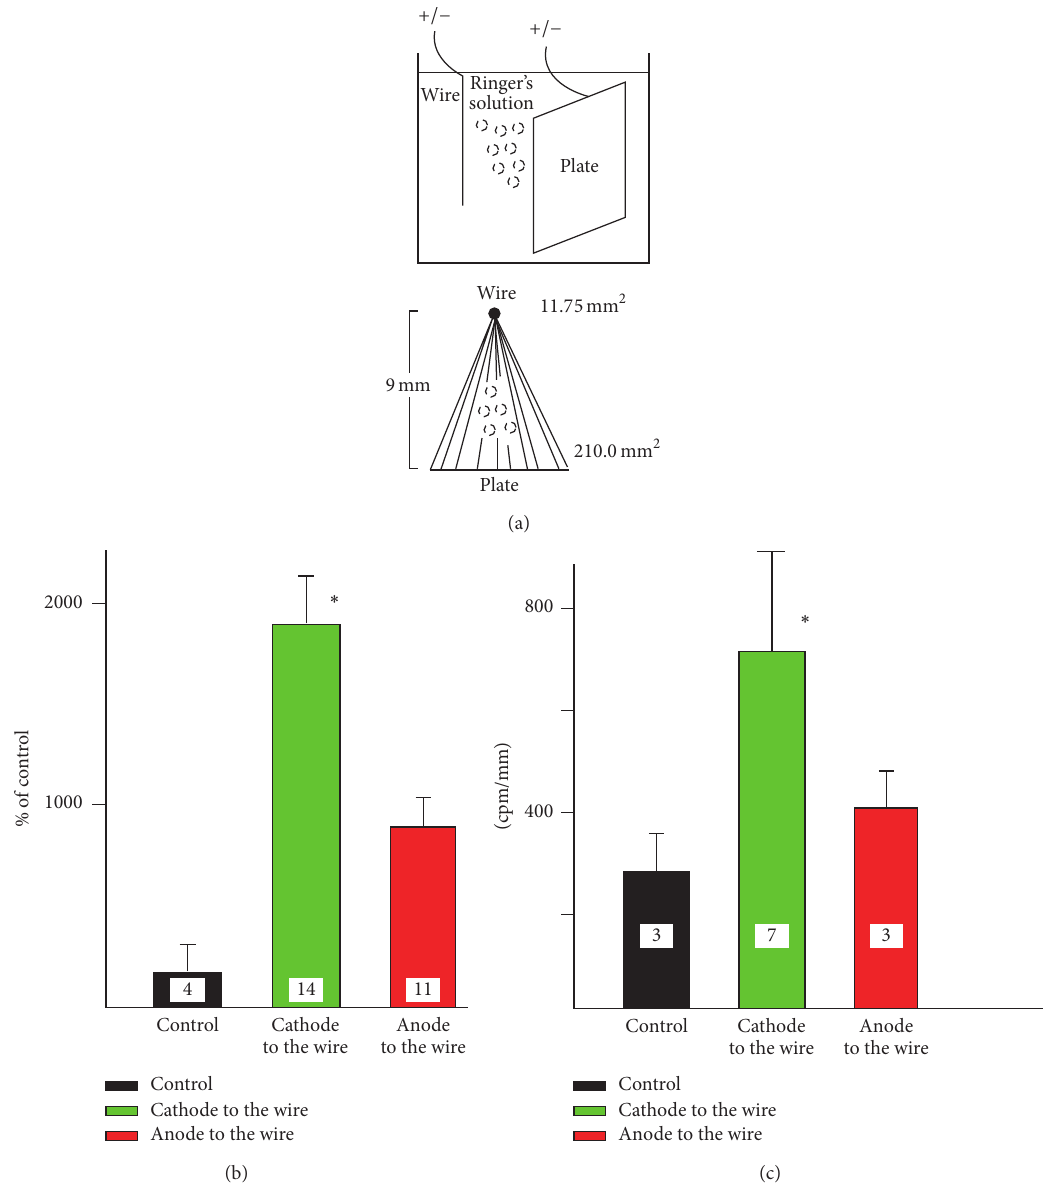
Figure 6: Accumulation of 45 Ca 2+ by synaptosomes and segments of the sciatic nerve stimulated with two electrodes of different areas. (a) An experimental setup. The stainless steel plate (210 mm 2 ) was inserted into the plastic tube at the distance of 9 mm from the stainless steel wire (11.75 mm 2 ). The preparations (synaptosomes or segments of the sciatic nerve attached to the wooden stick) were placed in the tube and stimulated with DC (3 󸀠 , 3 mA). The anode or cathode of DC was connected to either the wire or the plate. The broken lines in the lower panel of the figure illustrate hypothetical flow of the current. (b) The accumulation of 45 Ca 2+ by synaptosomes, while anode (black) or cathode (red) was connected to the wire. (c) The accumulation of 45 Ca 2+ by the segments of the sciatic nerve, while anode (black) or cathode (red) was connected to the wire; ∗ 𝑝 < 0.001 ; Mann–Whitney U